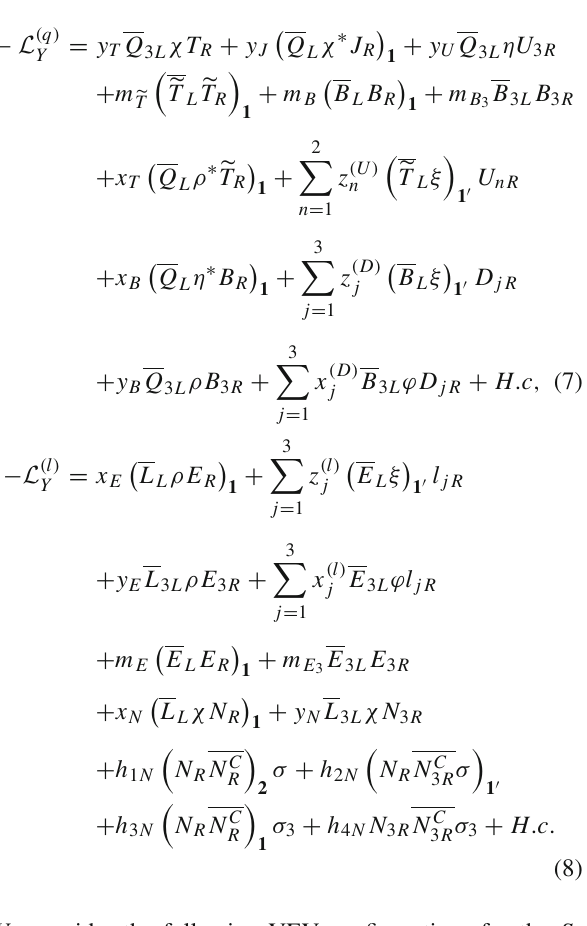
(cid:3) , n = 1 , 2 and i = 1 , 2 ,